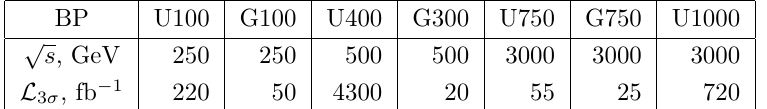
Table 5 . Center-of-mass energy and integrated luminosity required for a 3-sigma observation of the CW neutrino signal in electron-positron